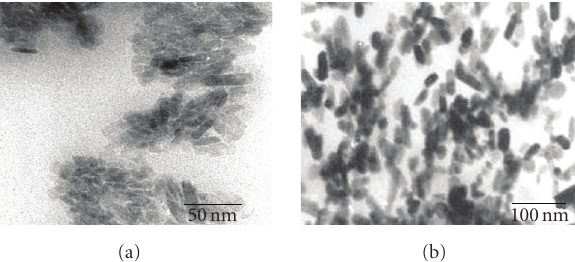
Figure 3: TEM micrographs of (a) HAp powders and (b) HAp/CSP nanocomposite (40% w/w).